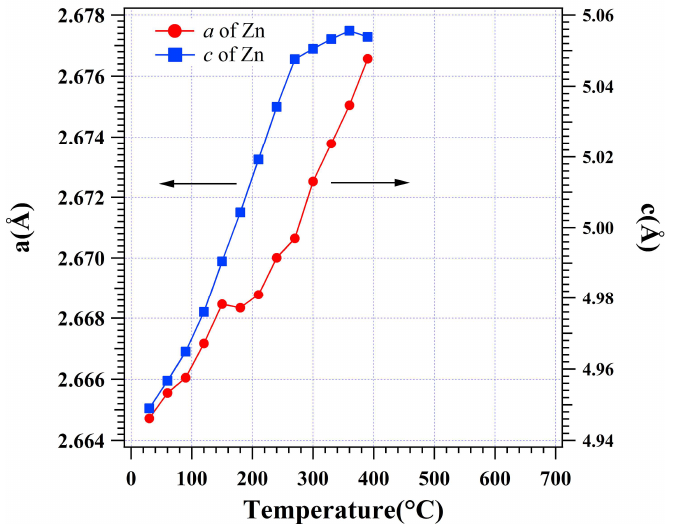
Figure 7. Lattice parameters for the β-Zn hcp unit cell based on sizes a and c in the dross